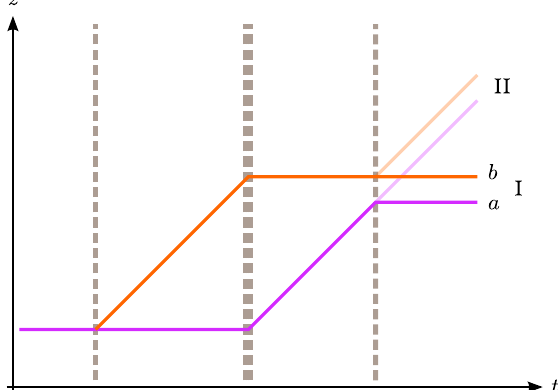
FIG. 12. Schematic representation of the central trajectories of the atomic wave packets in a light-pulse atom interferometer, where branches a and b correspond to the two interfering wave packets in exit port I. The example displayed here is a Mach- Zehnder interferometer with different times between the mirror pulse and the initial and final beam-splitter